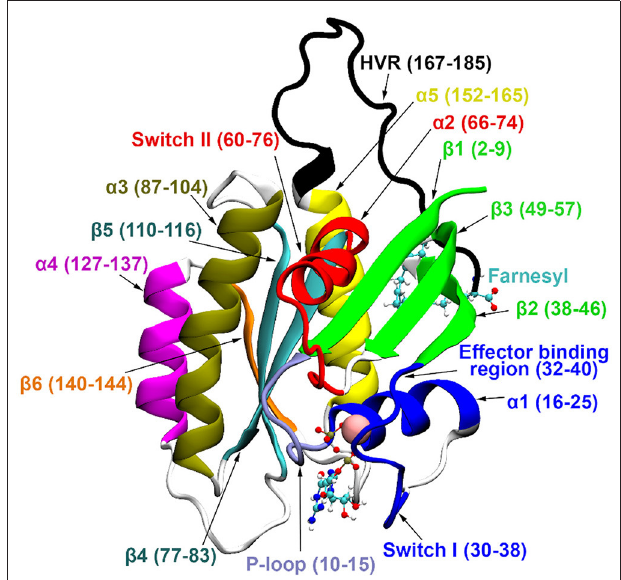
FIGURE 1 | K-Ras4B secondary structure elements. GDP and farnesyl are represented in CPK representation, Mg 2 + with vdW